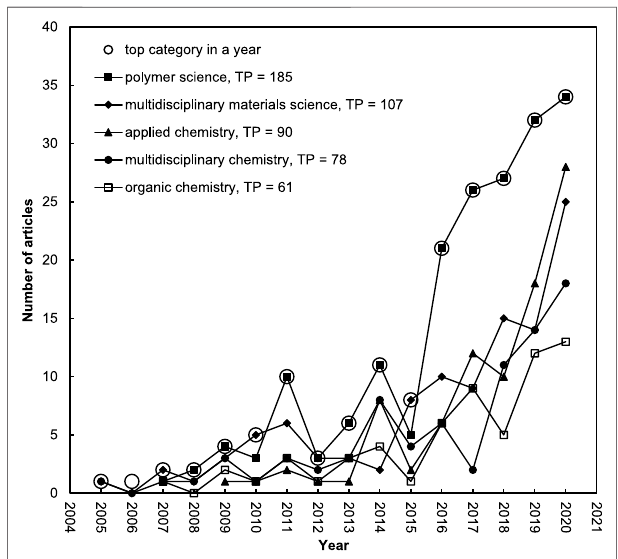
FIGURE 3 | Developments of the top fi ve Web of Science categories with TP >